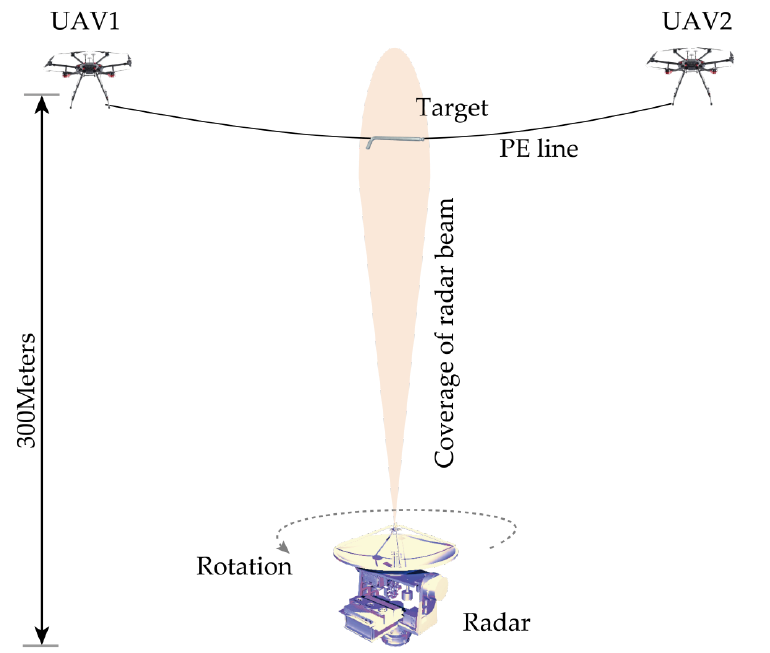
Figure 8. Schematic diagram of the experiment.